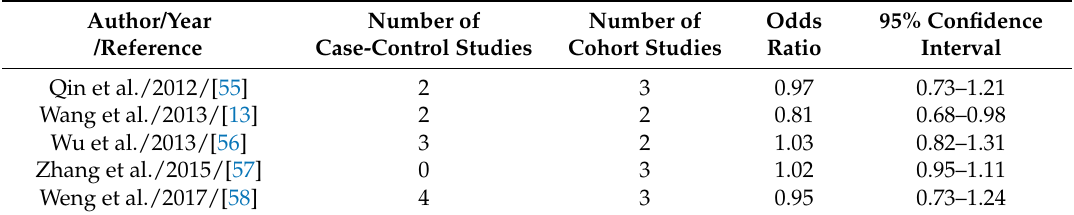
Table 2. Meta-analyses of the relationship between green tea consumption and bladder cancer